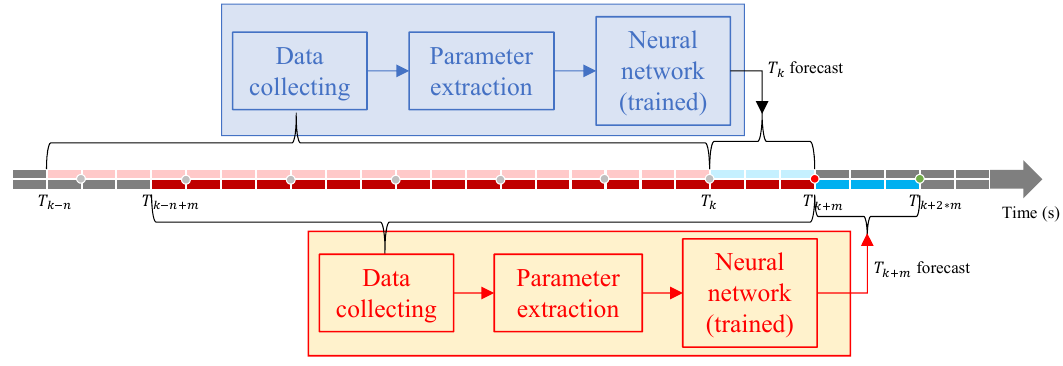
Figure 4. Steps 2 and 3 of prediction process: online identification and recursive